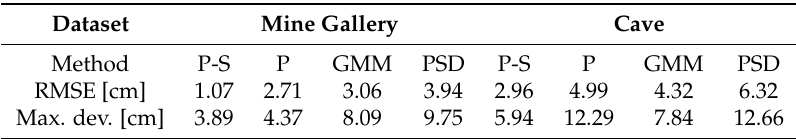
Table 2. Localization accuracy of our algorithms: parallel-serial (P-S) and parallel (P), and the reference methods: GMM [66] and PSD